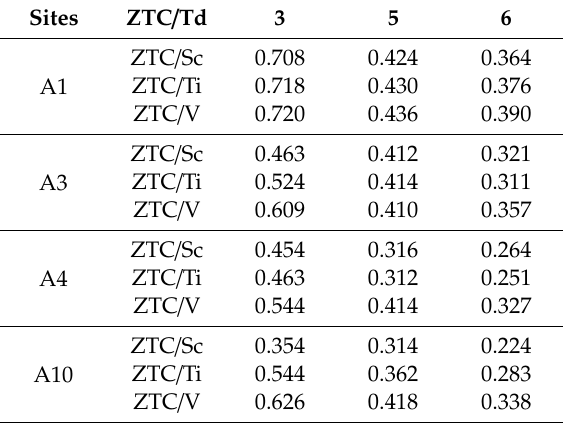
Table 2. Average adsorption energy (eV) of 3–6 H 2 molecules adsorbed around transition metal at each